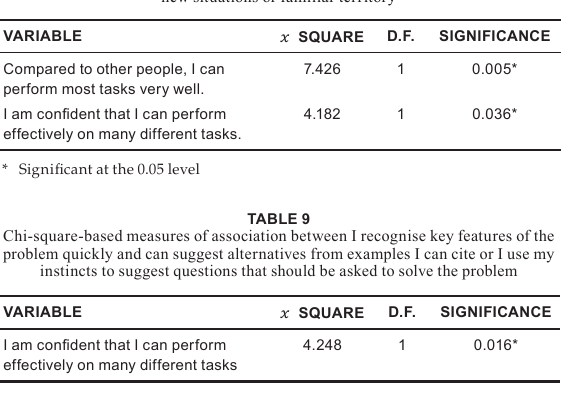
table 8 Chi-square-based measures of association between are you more comfortable in new situations or familiar territory